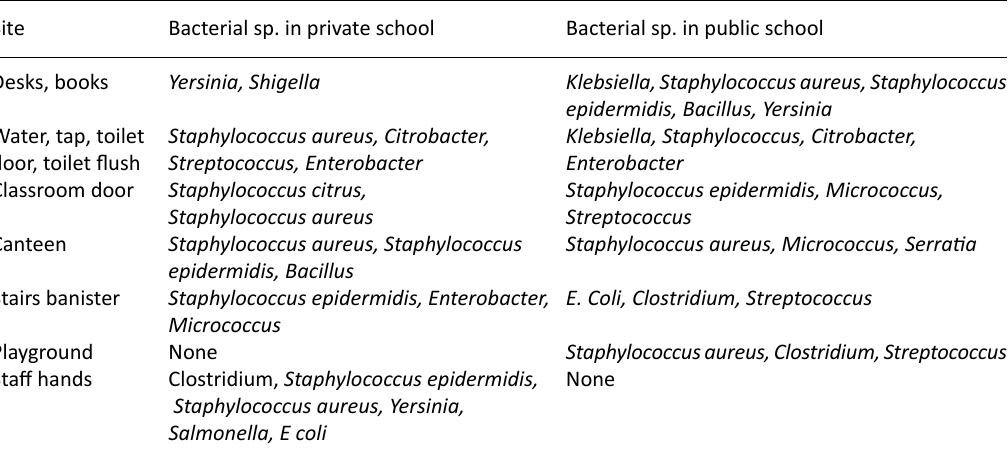
table 4. Specific types of bacteria in different locations in the two schools